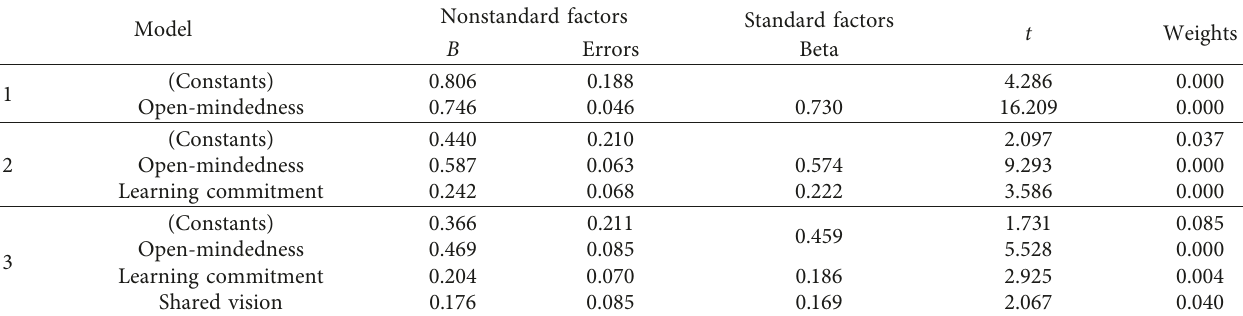
Table 5: Regression coefficient table of organizational learning on innovation performance.